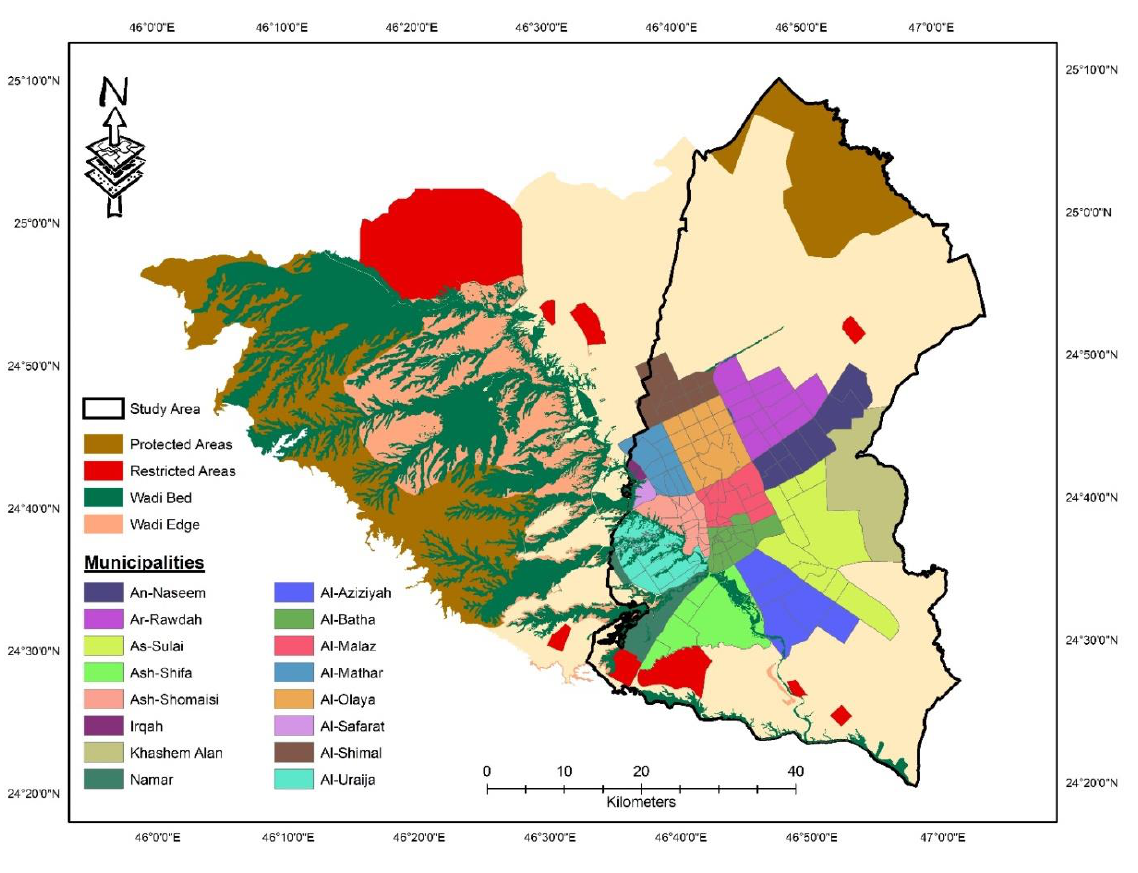
Figure 1. Study area boundary in the City of Riyadh